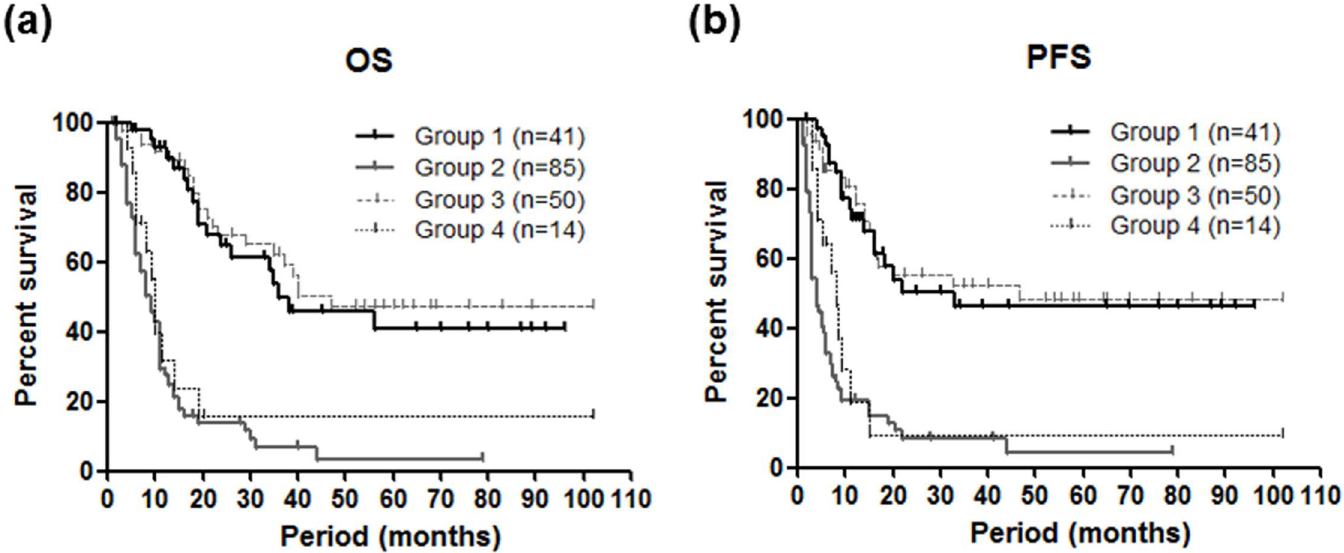
Fig 6. Overall survival (OS, left) and progression-free survival (PFS, right) among four groups divided according to the endoscopy and CT based response evaluations. Group 1, responderby both CT and endoscopy;group 2, non-responder by both CT and endoscopy;group 3, non-responder by CT but responderby endoscopy; group 4, responderby CT but no-responder by endoscopy.Different groupswas assessed using the Kaplan-Meier method and the Log rank test.